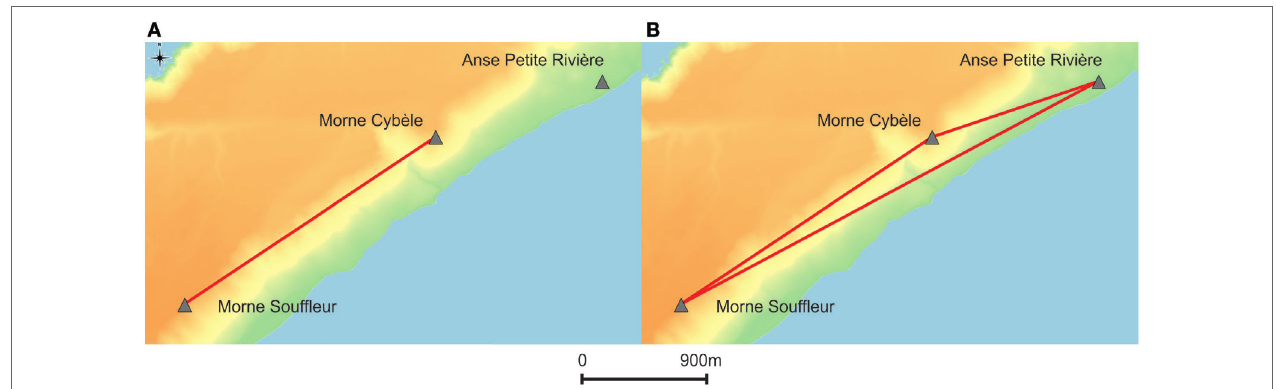
FigUre 2 | First-order visibility graph where directly intervisible nodes are connected (a) . The cumulative viewshed results in Figure 3D can be represented as a second-order visibility graph where a pair of nodes is connected if other locations are visible from both (B)